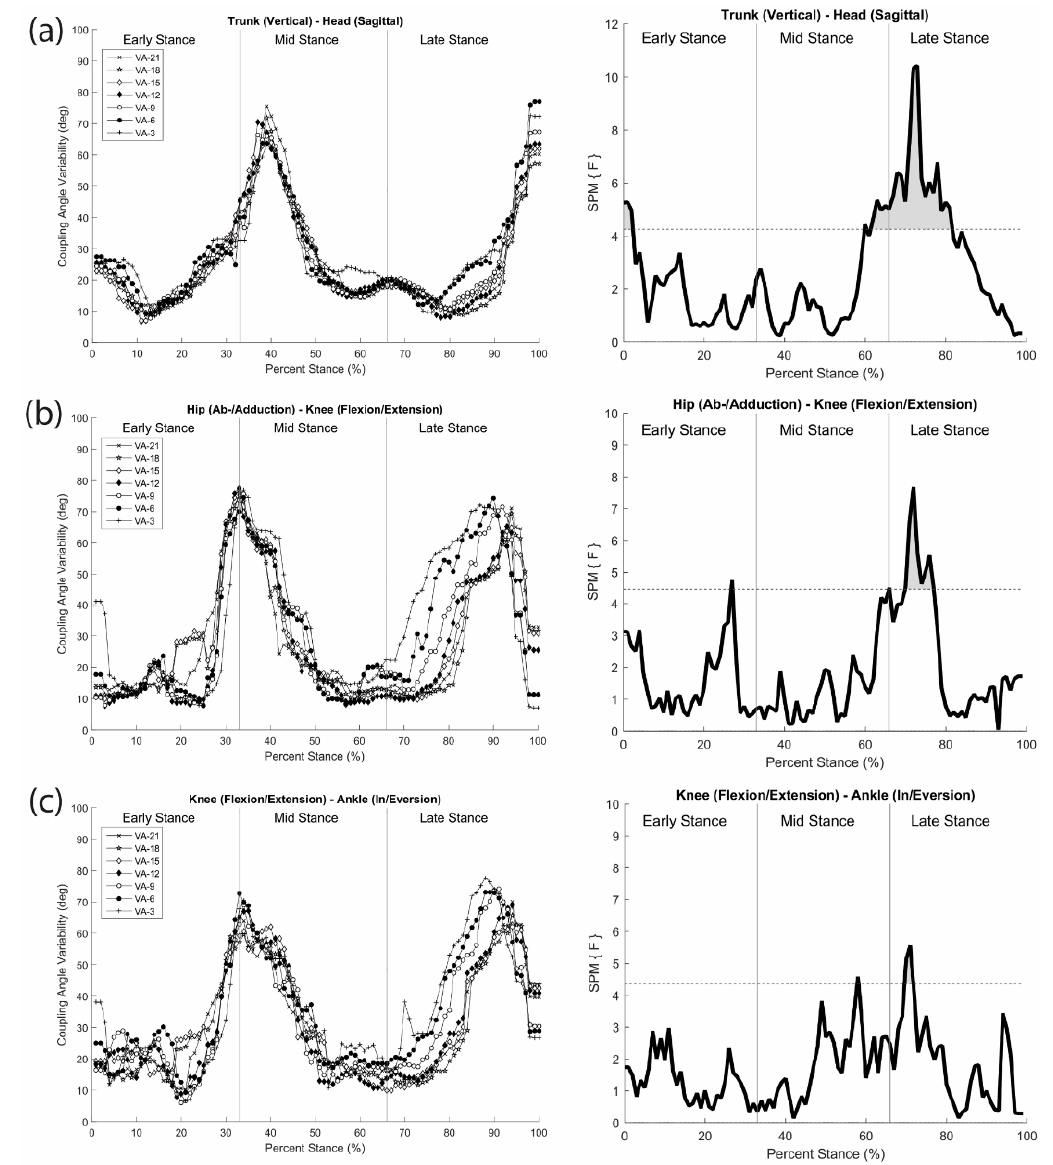
Figure 8. Coordination variability during stance in the head–trunk ( a ) and lower extremity ( b and c ) segment/joint couplings as a function of visual condition (left) and F (SPM{F}) values at each normalized time point (right). A horizontal dotted line in the right panel indicates threshold level in SPM statistics (Lim et al. [59] ). Note. SPM indicates a statistical parameter mapping, providing a statistical solution for the objective classical hypothesis testing for differences between biomechanical time-series datasets (Pataky et al. [60] ).